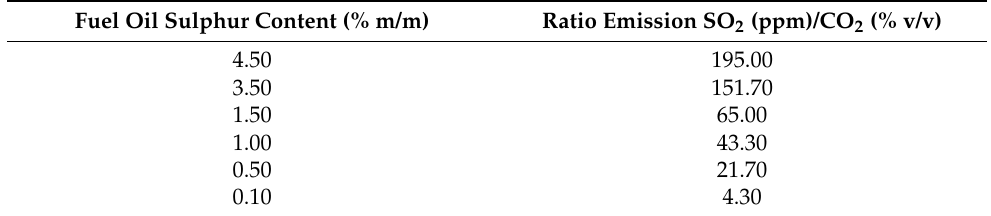
Table 2. Fuel oil sulphur limits recorded in regulations 14.1 and 14.4 and corresponding emission values